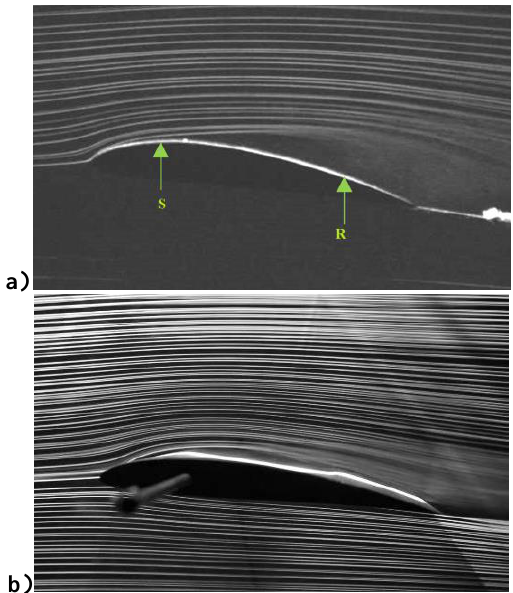
Fig. 3. Smoke-wire results for Re=5x10 4 , α=8º and z/s=0.4 a) uncontrolled case [19], b) partial flexible airfoil